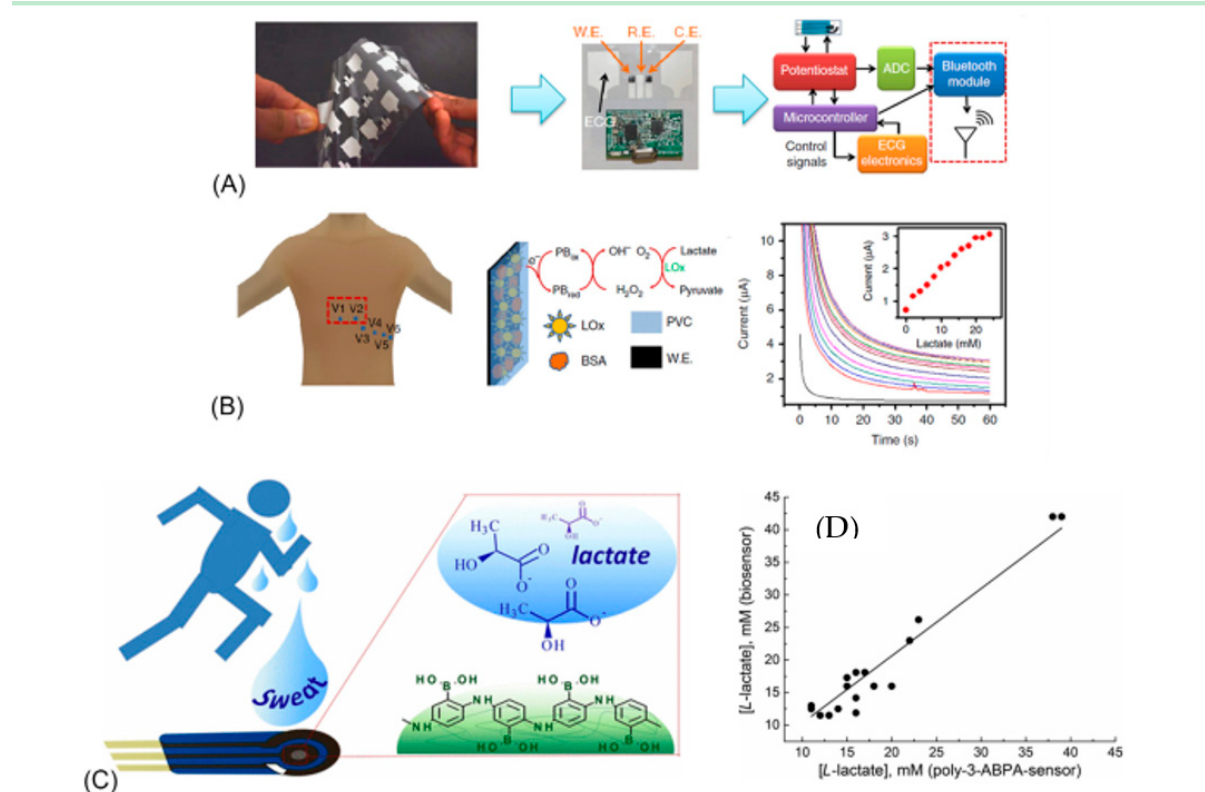
Figure 7. Device photographs of sweat-based sensor on body and its sensor features ( A , B ), schematic representations of screen- print, block diagram of the circuit, enzymatic sensing mechanism and amperometric response of wearable sweat- based lactate biosensor ( C ), schematic illustration of nonenzymatic lactate sensor in human sweat and correlation diagram for lactate measurement in 17 sweat samples collected from seven healthy human subjects measured using poly(3-APBA) sensor and with the flow-injection system equipped# with the biosensor ( D ) (reprint adapted with permission from Parlak et al., 2020 ; Ref. [17]. Copyright 2020 Elsevier Ltd.).